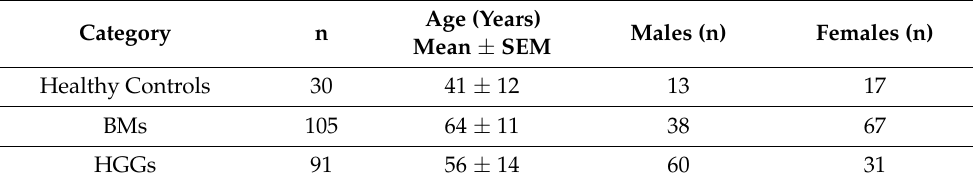
Table 1. Demographic and clinical features of healthy controls and patients with brain metastases (BMs) and high-grade gliomas